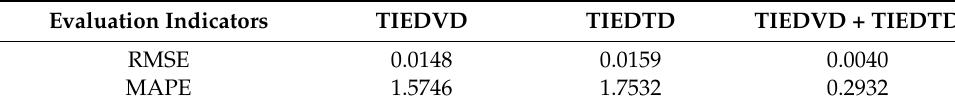
Figure 6. Comparison of different HIs. Table 2. Prediction RMSE and MAPE for different HIs.